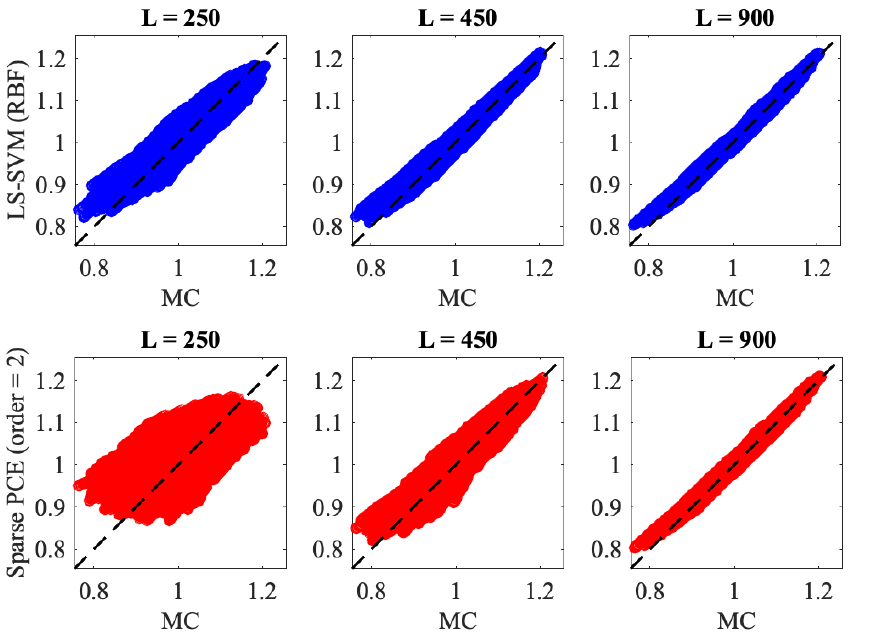
Figure 8. Scatter plots of the network node voltages for Case 1 ( d = 450 uncertain parameters) predicted by LS-SVM regression (top three panels) and sparse PCE (bottom three panels) surrogate models trained with an increasing number of samples, versus the results of MC simulation.